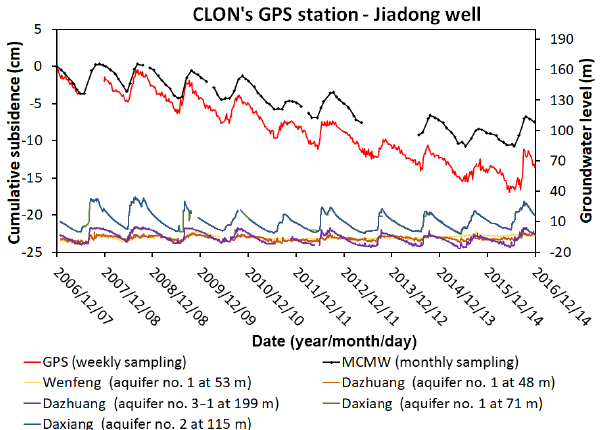
Figure 2. Cumulative subsidence of GPS data, MCMW data are in the left y -axis, and groundwater level variation, represented in right y